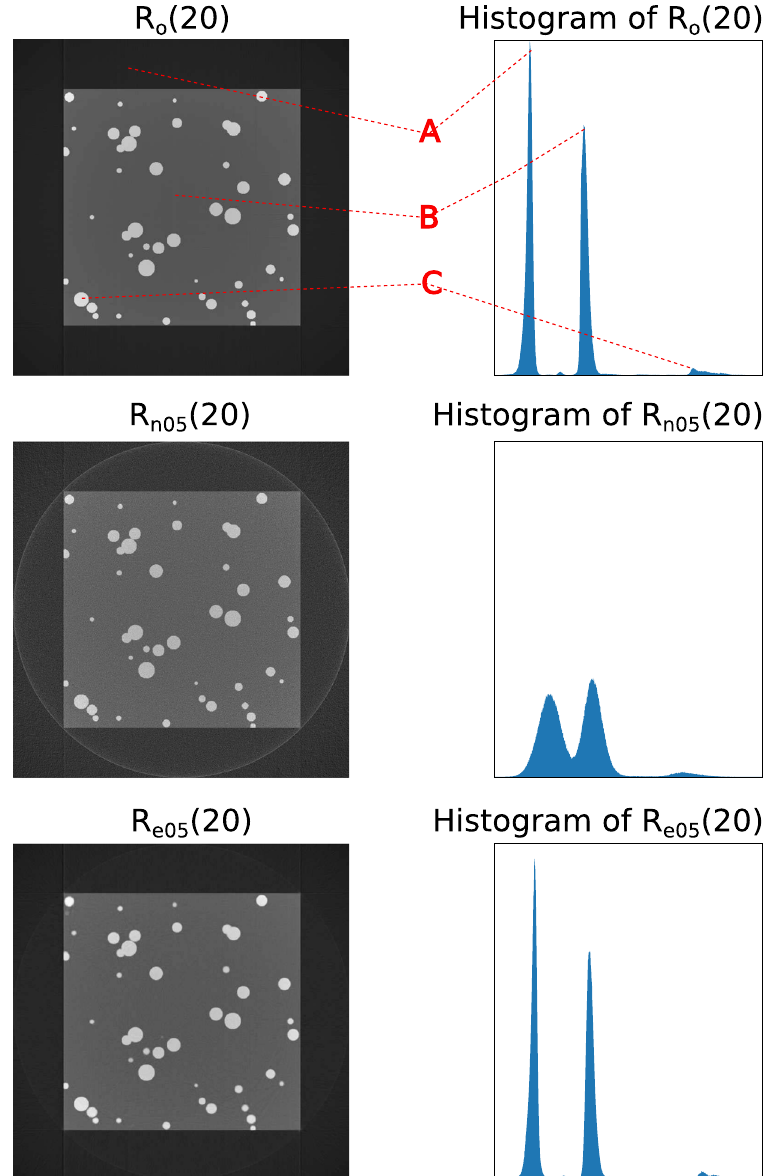
Figure 2. Reconstructed slice (left) and corresponding histograms (right). The top row is a slice of the ground truth reconstruction ( R o ); the middle row is the same reconstructed slice ( R n 05 ) from the projections with 5% noise ( P n 05 ); the bottom row is the same reconstructed slice ( R e 05 ) from the CNN enhanced projections ( P e 05 ). ‘A’, ‘B’ and ‘C’, correspond to the black region outside the object, the gray region inside the object and the white